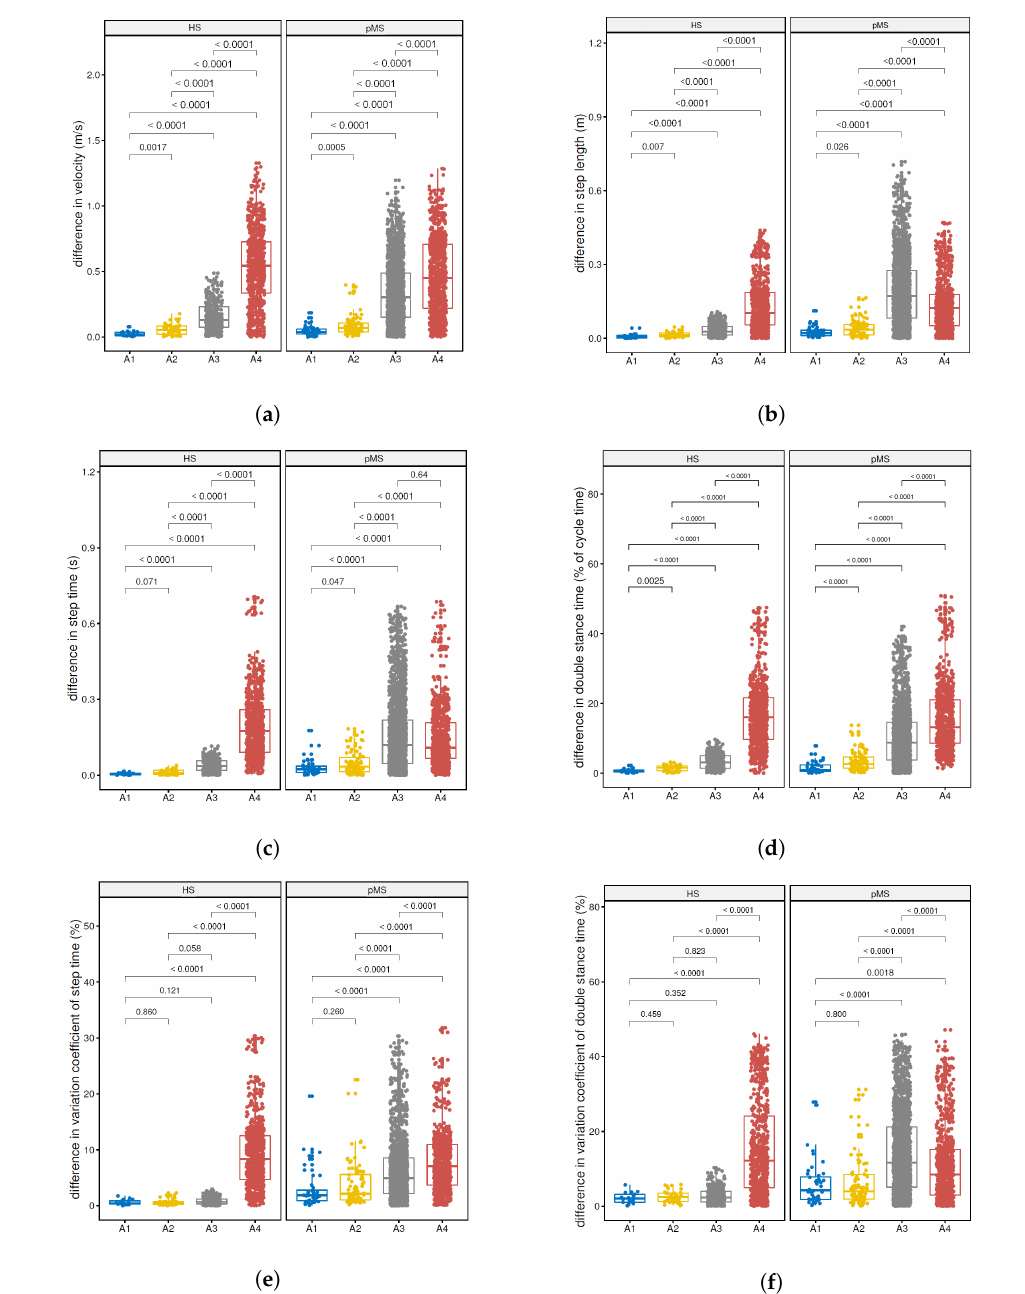
Figure 5. Intra-individual intra-session prediction (A1) vs. intra-individual inter-session prediction (A2) vs. intra-group inter-individual prediction (A3) vs. inter-group inter-individual prediction (A4) for both cohorts : ( a ) Average walking velocity; ( b ) step time; ( c ) step length; ( d ) double stance time; ( e ) coefficient of variation of step time; ( f ) coefficient of variation of double stance